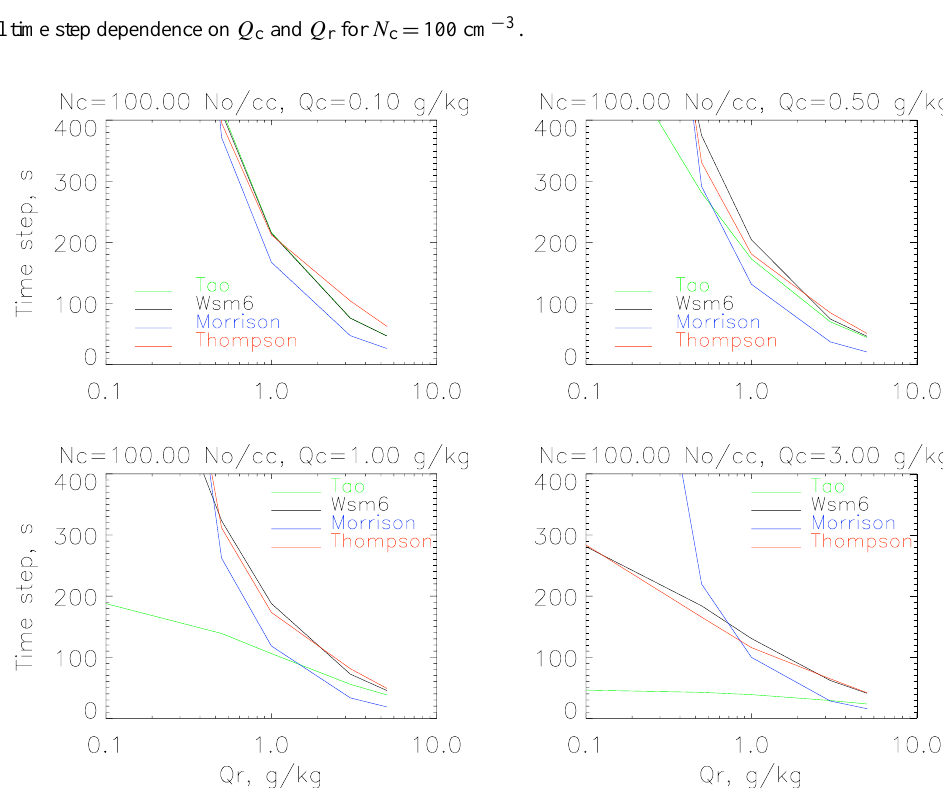
Fig. 4. Maximal time step dependence on Q r and Q c for N c = 100 cm − 3